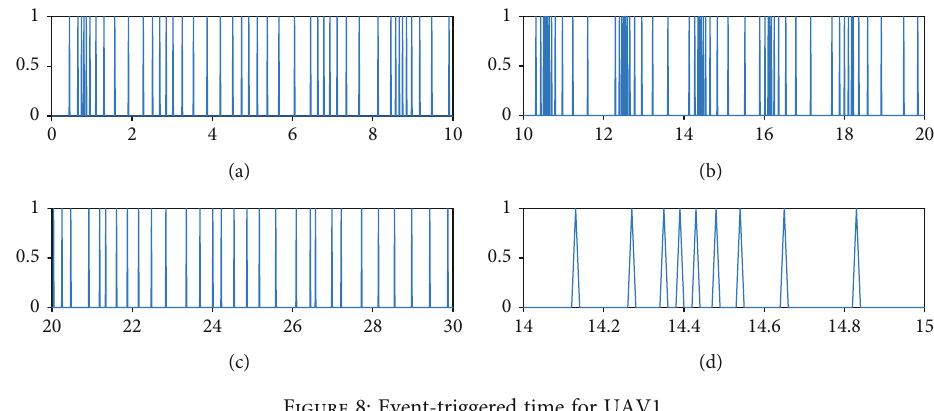
Figure 8: Event-triggered time for UAV1.